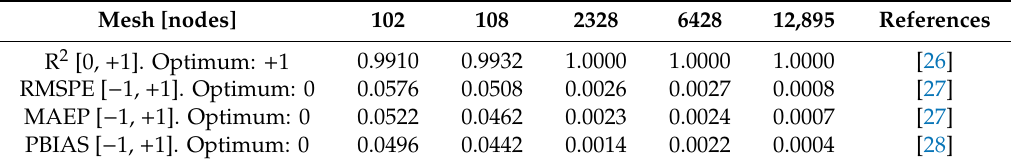
Table 6. Metrics for thermal simulation using [ M τ ] .